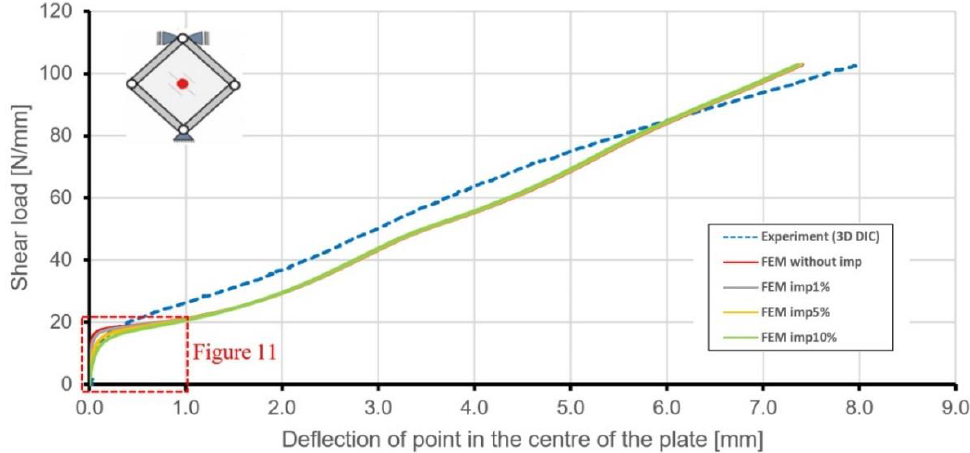
Figure 10. Comparison of shear load versus central point deflection curves, obtained for the stiffened plate by numerical calculations and experimental investigations (imp means geometrical imperfection).